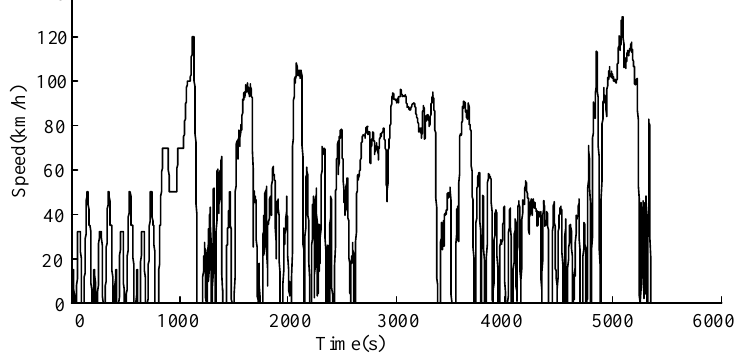
Figure 10. Time-speed relationship of the comprehensive test cycle conditions.